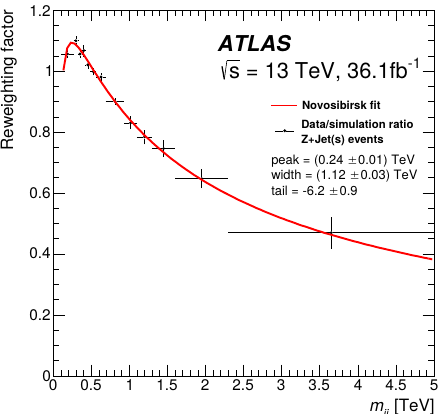
Figure 2 . Ratio between data and simulation for Z + jet(s) events collected in CR( e (cid:6) e (cid:7) ) and CR( (cid:22) (cid:6) (cid:22) (cid:7) ) as a function of the dijet invariant mass, with the result of the Novosibirsk (cid:12)t superim- posed. The (cid:12)tted values for the peak and width in TeV, and tail (unitless) are shown. The binning is adjusted to minimise statistical (cid:13)uctuations with 36.1 fb (cid:0) 1 of data.